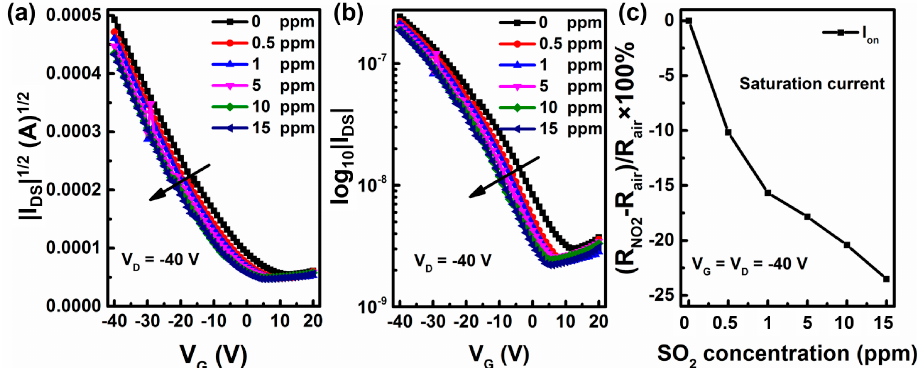
Figure 9. Transfer curves of devices B ( a , b ) and percentage variations of I on ( c ) under a specific concentration of SO 2 .